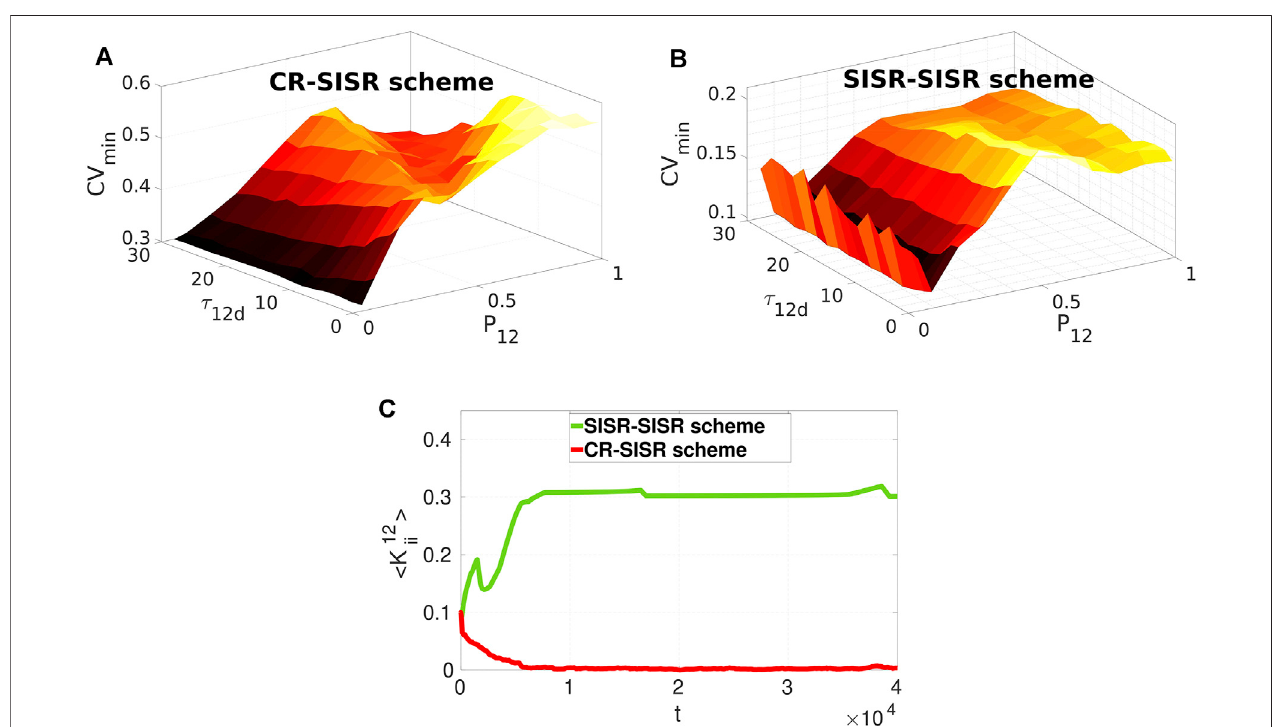
FIGURE7| MinimumCVagainstthemultiplexingpotentiationadjustingrate P 12 anddepressiontemporalwindow τ 12d forlayer1exhibitingSISRwhenmultiplexed tolayer2exhibitingCRandSISR inPanels (A) and (B) ,respectively.TheSISR-SISR schemeoutperformstheCR-SISRschemeinenhancing SISR inlayer1intheentire ( τ 12d , P 12 ) plane. Parameter values in panels (A) and (B) are the same as in ( Figure 6A ) with τ 12 = 350 and τ 12 = 1,000 in the CR-SISR and SISR-SISR scheme, respectively. Panel (C) shows the time-evolution of population-averaged inter-layer synaptic weights 〈 K 12 ii 〉 with an initial normal distribution of mean 0.1 and standard deviation 0.02 at the values of P 12 , τ 12d , and σ 1 (see main text) at which CV min achieves it lowest value in CR-SISR and the SISR-SISR schemes. LTP (LTD) favours the SISR-SISR scheme (CR-SISR